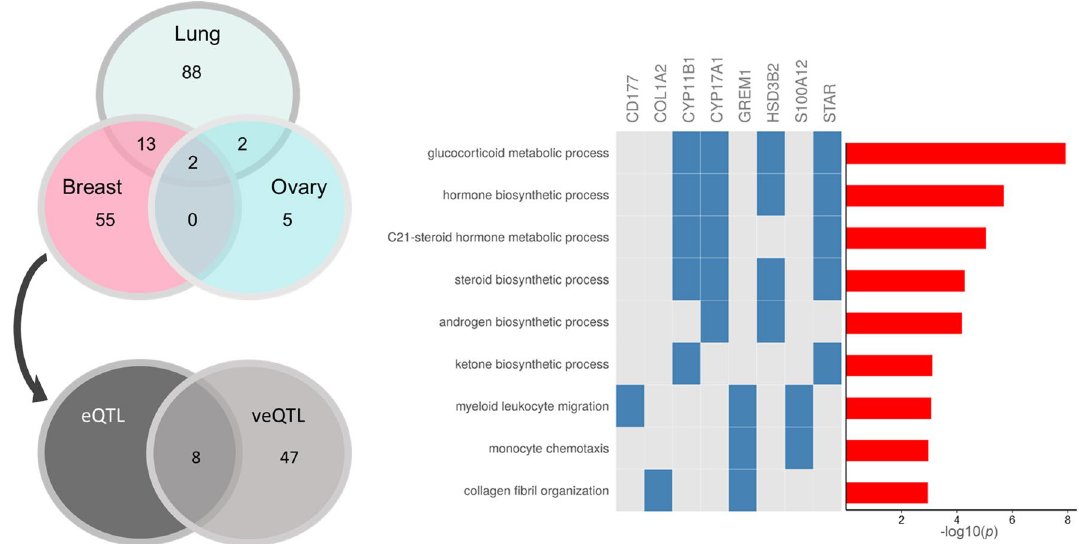
Figure 4. Pathway enrichment of candidate breast cancer risk genes identified through veQTL analysis. Fifty- five gene SNP pairs were observed only in breast tissues, 47 of these were veQTL but not eQTL associations. The candidate genes identified by these 47 associations were enriched for pathways involved in C21-steroid hormone metabolic process. The significance of pathway enrichment, − log10( p ), are shown graphically alongside a heatmap for genes involved (in blue) in the respective pathways. Pathway analysis was performed in R using GO terms and using the DOSE and ClusterProfiler